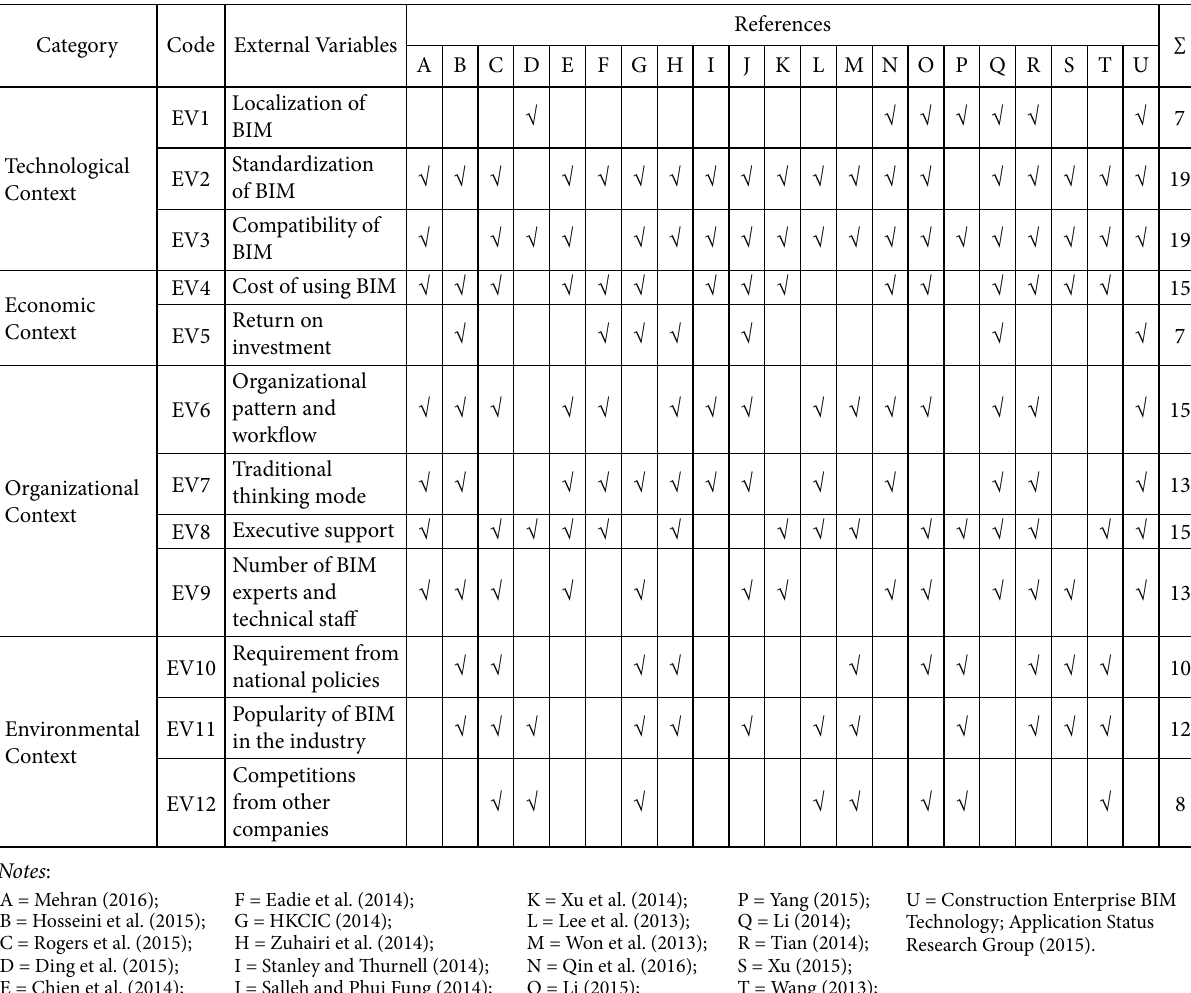
Table 3. A summary of literature on external variables in the BIM TAM-TOE